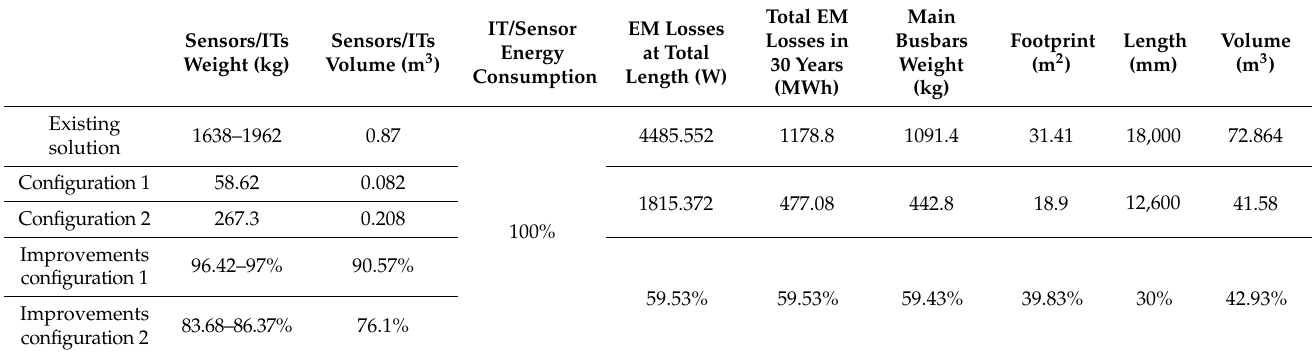
Table 14. Overall switchboard